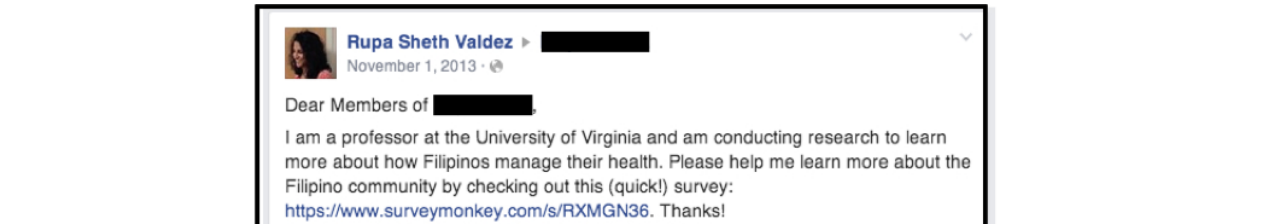
Figure 2. Post to Filipino-American groups and